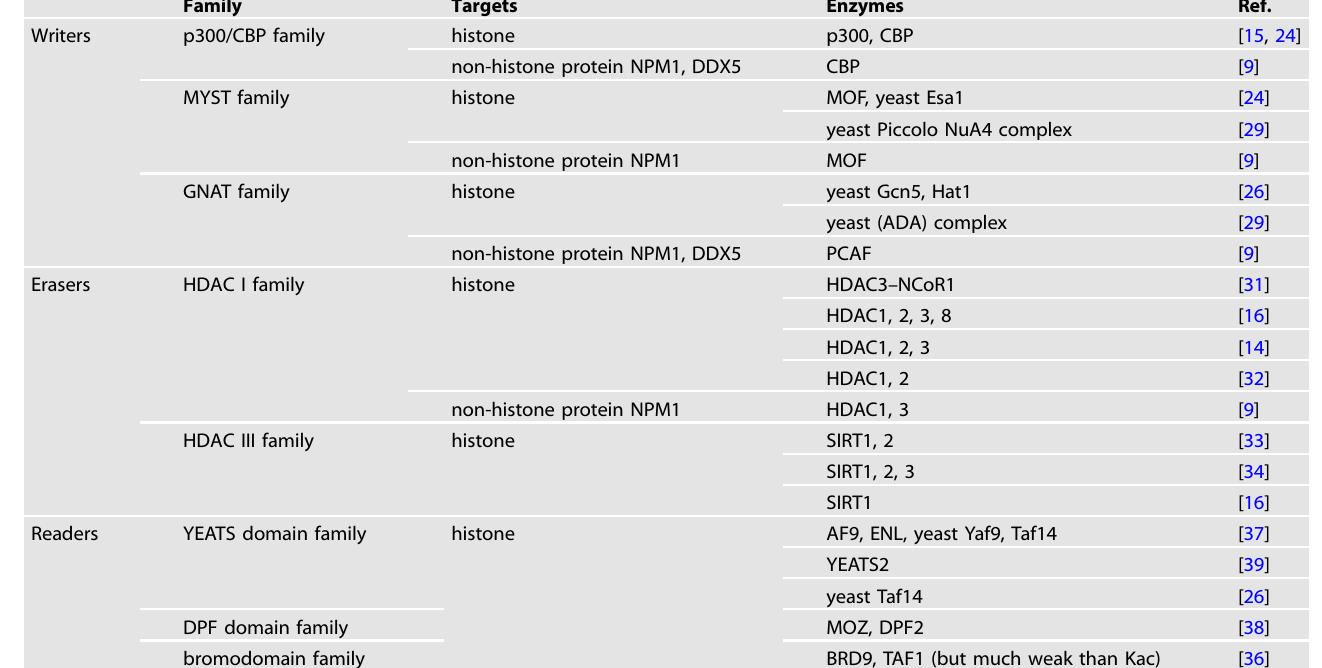
Table 1. writers, erasers and readers of Kcr.